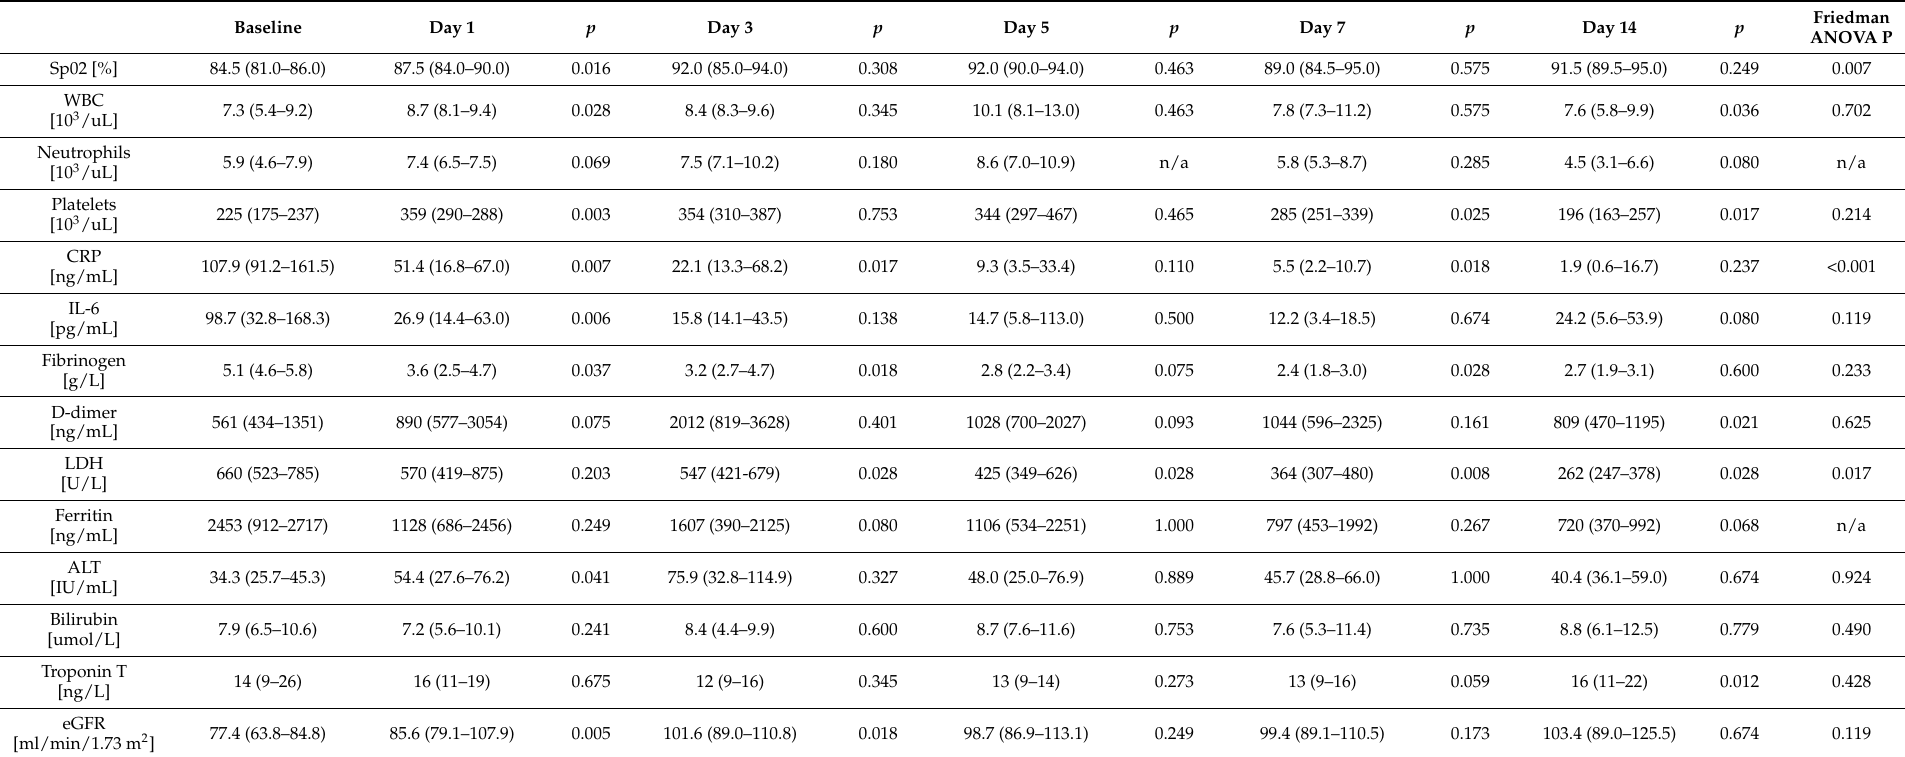
Table 2. Dynamics of serum proinflammatory markers and safety parameters in subjects treated with low-dose radiation therapy for severe COVID-19 (median, 25–75% CI, P statistical significance vs. previous